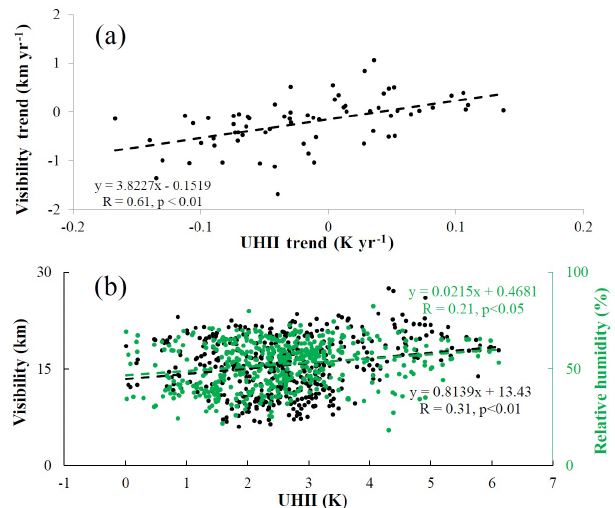
Figure 3. (a) Clear-day visibility trend (unit: kmyr − 1 ) shown as a function of the UHII trend (Kyr − 1 ), and (b) clear-day visibility (unit: km) and relative humidity shown as a function of UHII (unit: K). The period is 2001–2015. The black and green lines are the linear best-fit line through the points. Sample numbers of (a) and (b) are 68 and 510, respectively. The least-squares regression equa- tion is given in each panel. The coefficient correlation ( R ) and p value are also given, and all of them pass confidence test in